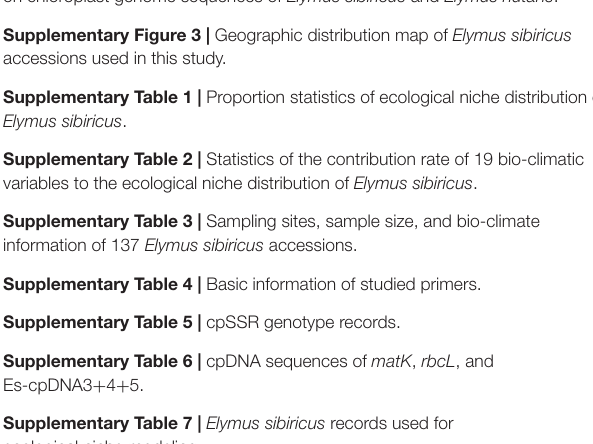
Supplementary Figure 1 | (cid:49) K estimation based on the structure harvester of cpSSR. Supplementary Figure 2 | Hotspot regions identified by mVISTA blasting based on chloroplast genome sequences of Elymus sibiricus and Elymus nutans . Supplementary Figure 3 | Geographic distribution map of Elymus sibiricus accessions used in this study. Supplementary Table 1 | Proportion statistics of ecological niche distribution of Elymus sibiricus .